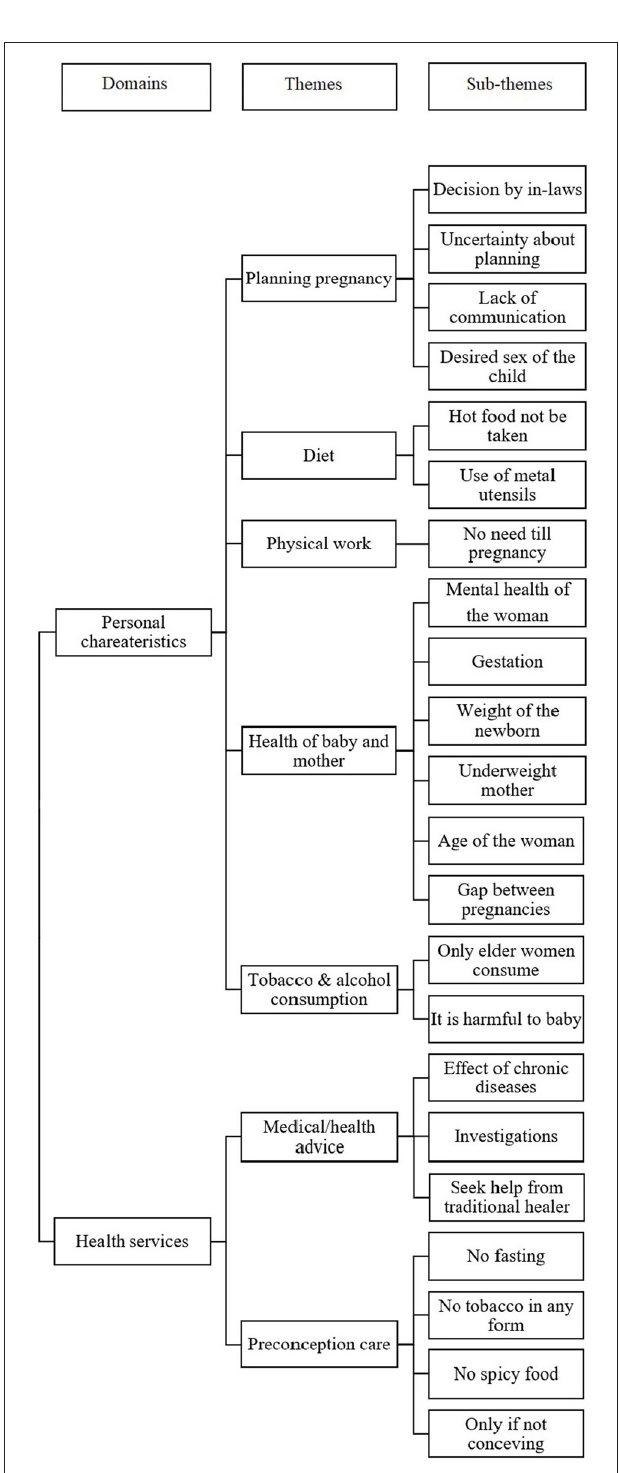
FIGURE 2 | Emerged themes and sub-themes after focus group discussions.